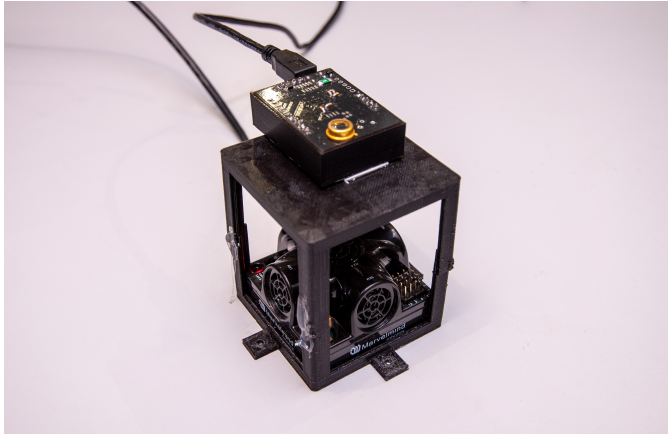
Figure 6. Image of the custom designed receiver in the experimental setup, the device on the top is the Visible Light Positioning (VLP) receiver and the device on the bottom is the mobile node of the acoustic ground truth system (Marvelmind Robotics Super-NIA-3D).